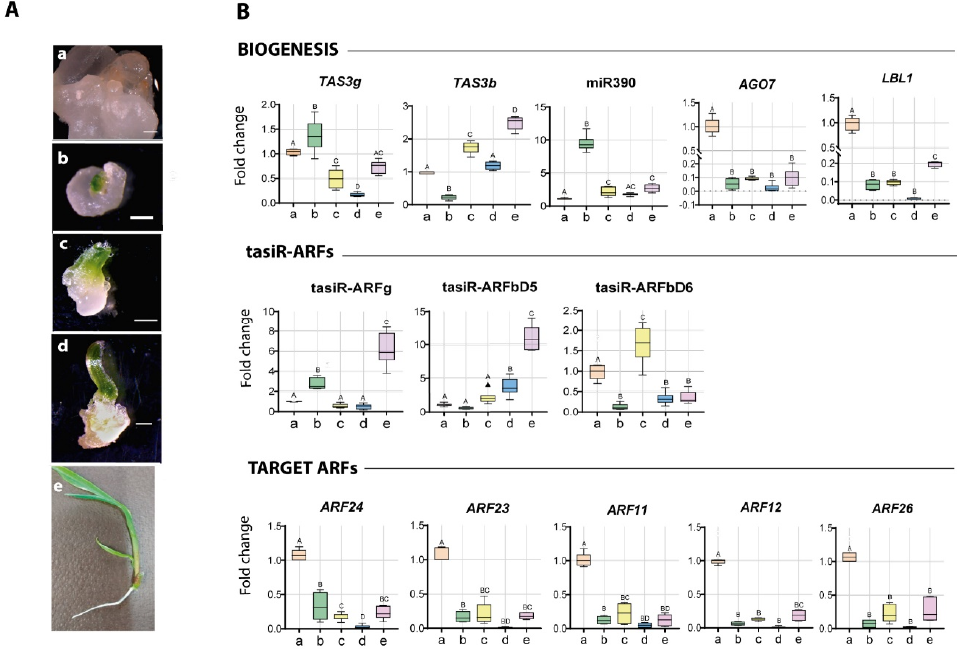
Figure 2. In vitro maize regeneration is accompanied by increase in tasiR-ARF production and ZmARF3 transcripts down-regulation. ( A ) stages of in vitro regeneration of Tuxpeño VS-535: ( a ) EC, ( b ) 1st stage of development, ( c ) 2nd stage of development, ( d ) 3rd stage of development and ( e ) plantlet. ( B ) tasiR-ARF pathway components abundance was analyzed by RT-qPCR at each regeneration stage. Upper charts depict the elements involved in tasiR-ARFs biogenesis. Middle panel shows mature tasiR-ARFs derived from TAS3b and TAS3g precursors. Lower charts indicate the abundance of ZmARFs from the ARF3 family in maize targeted by tasiRNAs. Fold change represents abundance relative to the EC and normalized by U6 snRNA internal control for tasiR-ARFs or 18S rRNA for long transcripts. The results were obtained from two independent biological replicates ( n = 2) with three technical replicates for each one ( n = 6). For multiple comparisons, data were subjected to one-way analysis of variance (one-way ANOVA) and differences between the means were compared by the Tukey post-hoc test. Bars that do not share at least a common letter differ significantly ( p < 0.05).